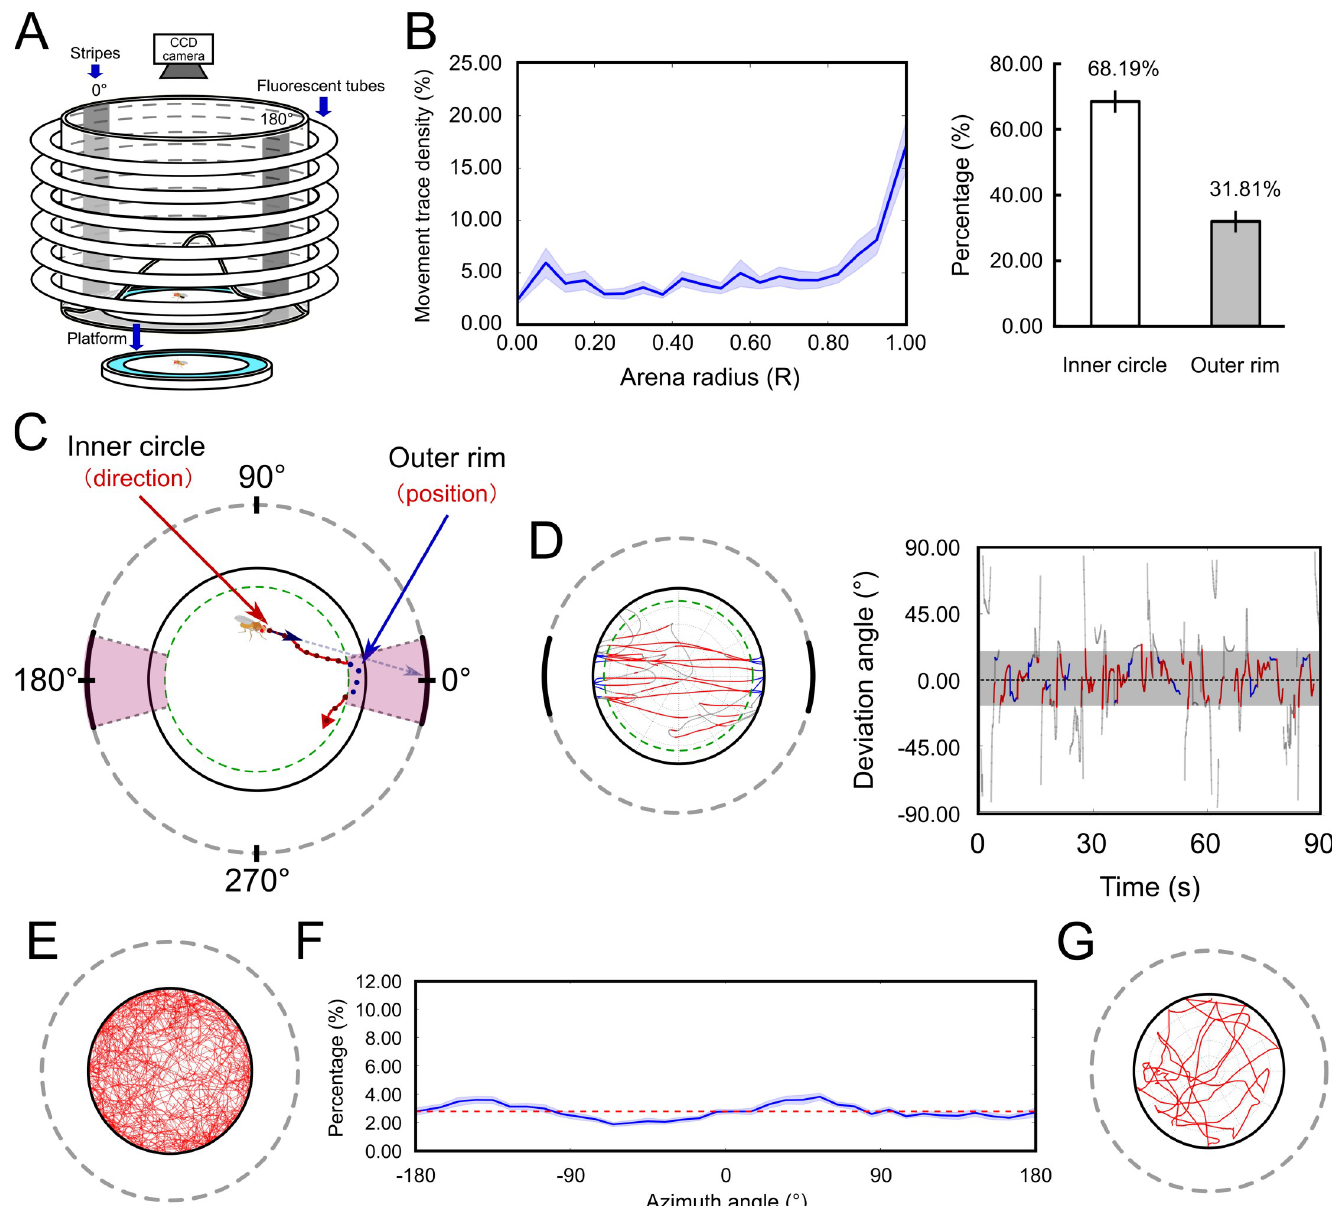
Fig 1. Schematics of the arena for the task and measurement of the deviation angle. (A) The behavioral arena. A circular platform was surrounded by water and by a screen illuminated by six circular fluorescent tubes. Two vertical dark stripes made of black cardboards were placed on the screen and served as the visual landmarks. In each trial, a single fruit fly was placed on the platform and allowed to move freely for 90 s. (B) (Left) The movement trace density (per unit area) for the w + flies in the arena shown in (A). The x-axis is the normalized radial position R on the platform with 0.0 and 1.0 corresponding to the center and the edge of the platform, respectively. The shaded area indicates the standard error of the mean. The trace density is significantly larger in R > 0.85 than in R < 0.85. (Right) The percentages of time flies spent in R > 0.85 and R < 0.85. (C) In the behavioral task, we recorded the trace of the fruit fly and calculated the deviation angle for each video frame. In the inner circle ( R < 0.85, the dashed green circuit), the deviation angle was determined by the projection of the movement vector on the screen (0˚ in this case), while in the outer rim ( R > 0.85, between the dashed green circuit and the black solid circuit) the deviation angle was determined by the position of the fly in terms of the azimuth angle. See Materials & Methods for the detail. (D) Left: A typical trace of a fly with 30˚-stripes. The red and blue lines indicate the stripe-fixation movement in the inner circle and the menotaxis in the outer rim, respectively. The gray lines indicate the non-approaching movement. Right: The movement trace represented by the deviation angle as a function of time. The colors follow the same definition as in the left panel. (E) Traces of 25 single flies in the all-bright (no stripe) condition for 90 s. (F) The distribution of azimuth angle of the same data as in the panel (E). The red line denotes the mean ( � 2.78) of the distribution. The shaded area indicates the standard error of the mean. (G) A typical trace of a single fruit fly in the all-bright condition.